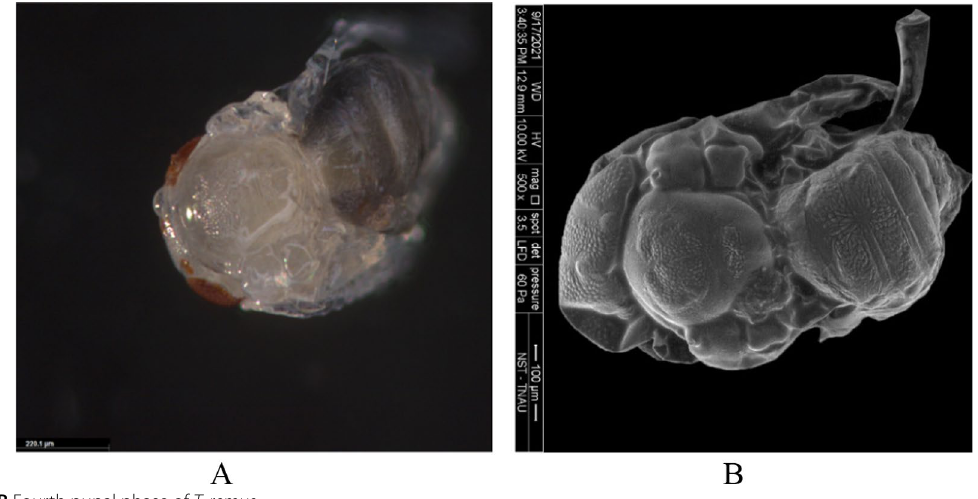
Fig. 10 A, B Fourth pupal phase of T. remus